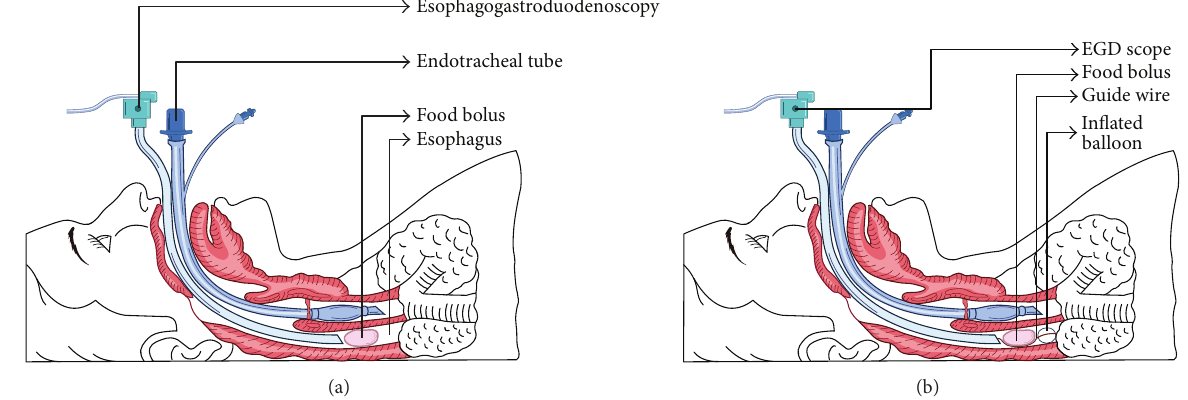
Figure 2: Schematic diagram showing the impacted foreign body in the proximal esophagus (a) and removal of the FB by inflating the balloon distal to it